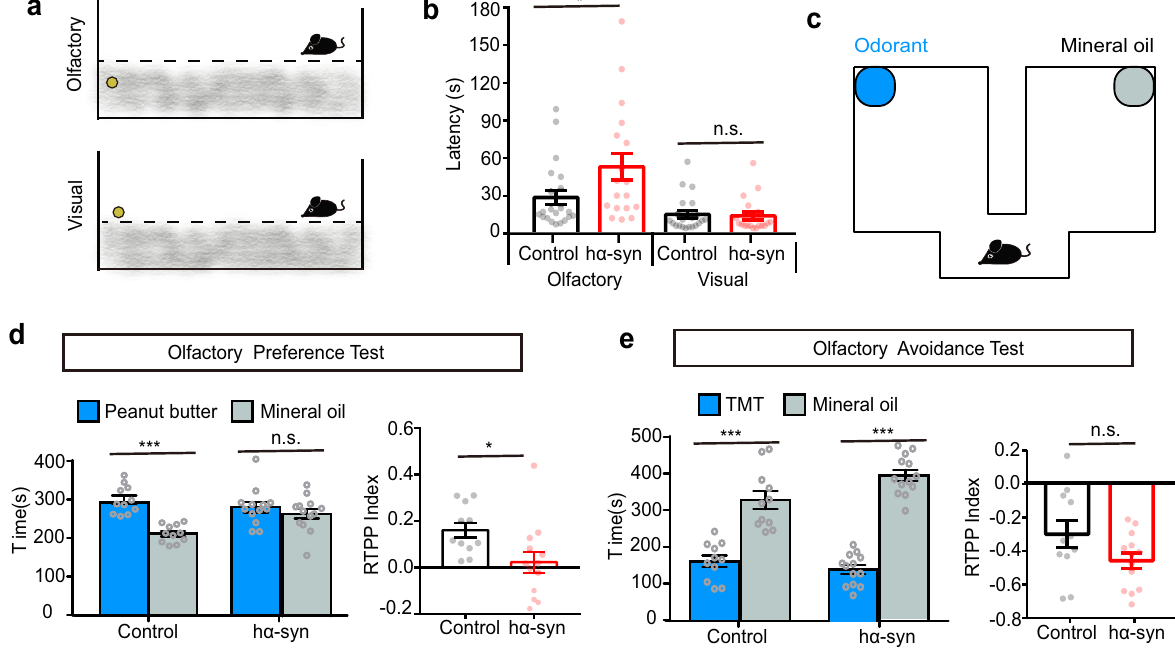
Fig. 2 Overexpressing α -synuclein in the OB impairs olfactory function in mice. a Schematic of the buried food pellet test. b Latency to locate a food pellet that is buried (Olfactory) or on the surface of the bedding (Visual) in control ( n = 21) and h α -syn ( n = 18) mice. c – e Olfactory preference/avoidance test. c Schematic of the test chamber. d Time spent by control ( n = 11) and h α -syn mice ( n = 13) in the chamber with peanut butter (blue) versus mineral oil (green) in the olfactory preference test. e Time spent by mice ( n = 11 for control group and n = 13 for h α -syn group mice) in the chamber with TMT (blue) versus mineral oil (green) in the olfactory avoidance test. The RTPP index indicates the degree of preference for peanut butter ( d ) or TMT ( e ). * p < 0.05; *** p < 0.001; n.s. not signi fi cant. Data are presented as mean ±